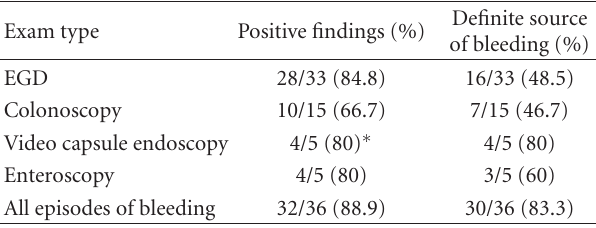
Table 3: Yield of endoscopic exams.